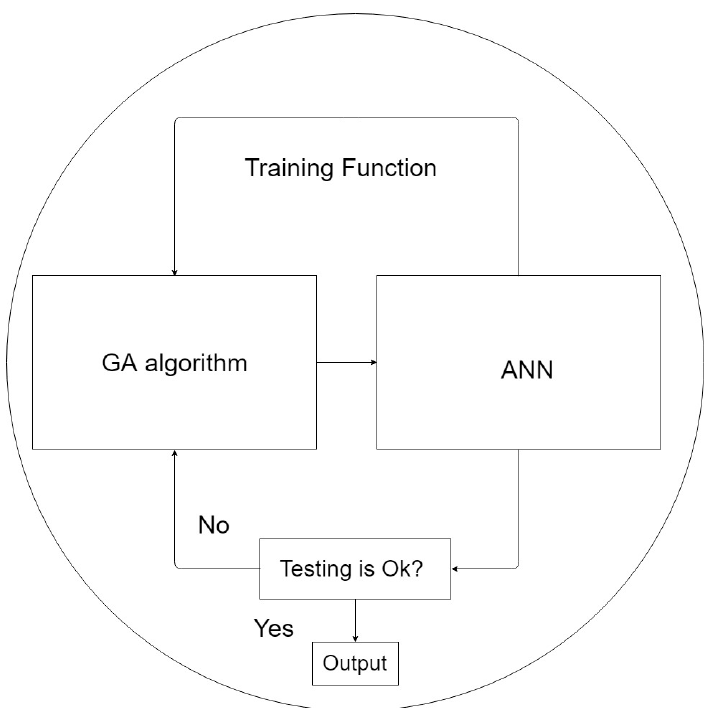
Figure 2. A view of genetic algorithm - artificial neural network (GA-ANN) algorithm.